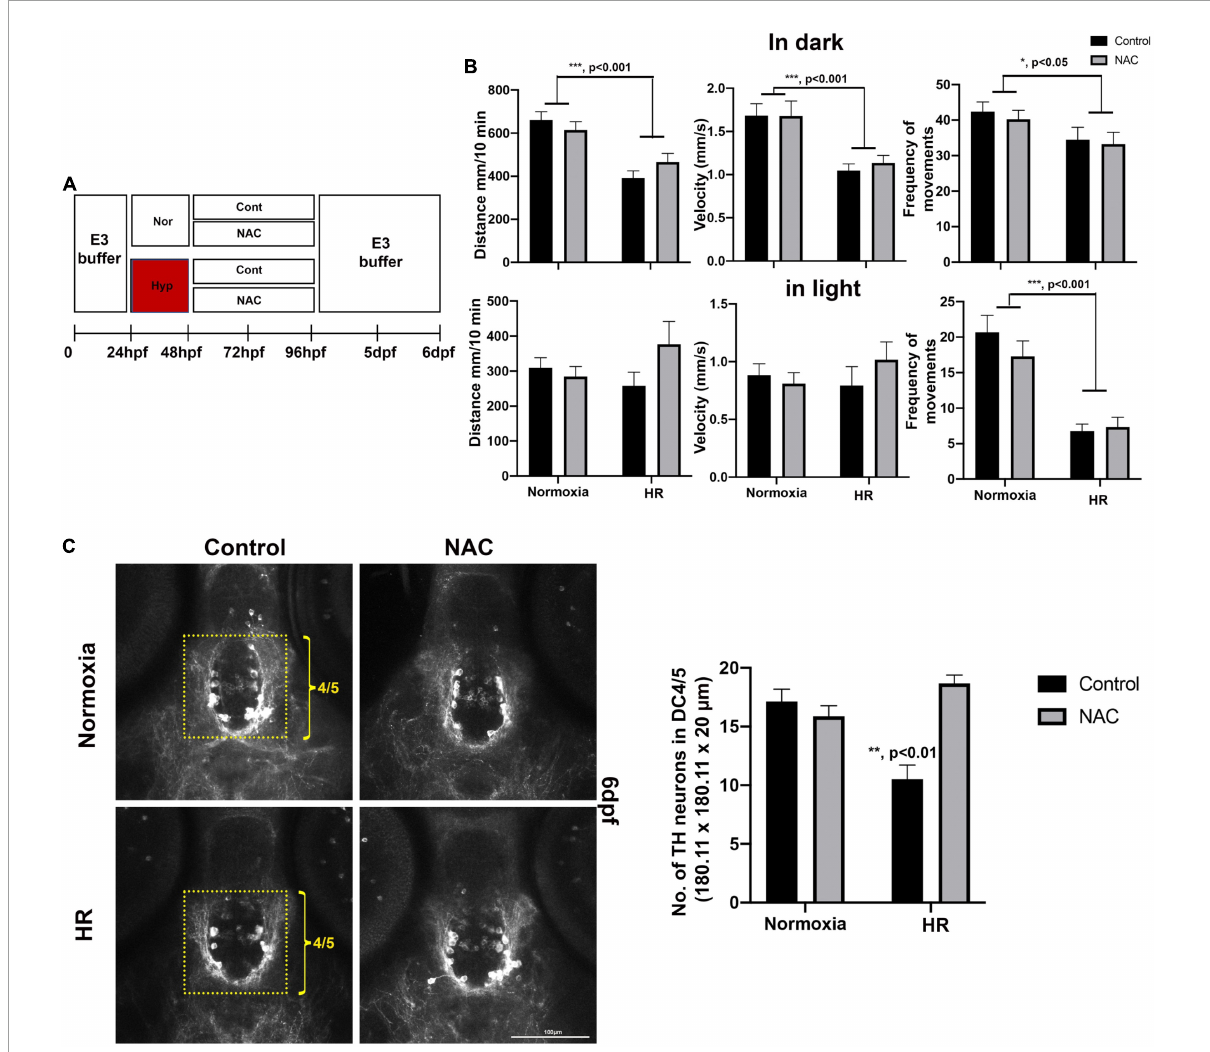
FIGURE6 (A) A schematic diagram for NAC treatment procedures with HR and the effects of NAC on swimming development and DC4/5 TH + neurons at 6 dpf. (B) Behavioral data in normoxic control ( n = 72), in normoxic NAC ( n = 70), HR control ( n = 51), and HR NAC ( n = 64) were analyzed by two-way ANOVA followed by Tukey’s post hoc test. (C) The Z-stack, confocal images of anti-TH at 6 dpf in the DC4/5 area (180.11 µ m × 180.11 µ m × 20 µ m) in normoxic control ( n = 6), normoxic NAC ( n = 8), and HR control ( n = 6), and HR NAC ( n = 12) analyzed by two-way ANOVA followed by Tukey’s post hoc test. * p < 0.05, ** p < 0.01, and *** p <